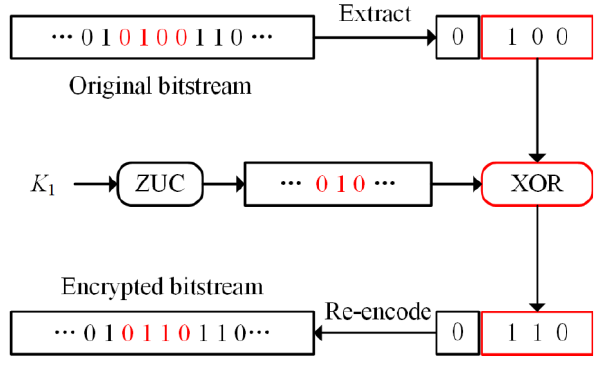
Figure 5. IPM encryption.